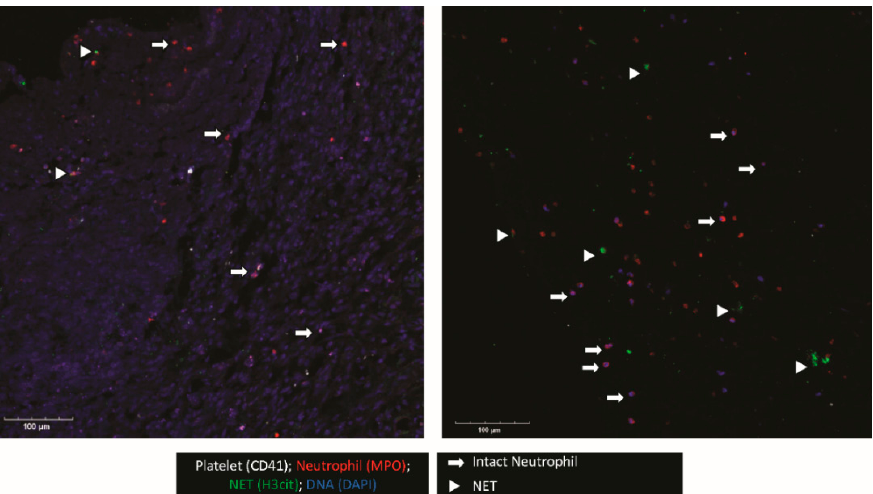
Figure 1. NETs and platelets are present in NASH outer membranes. The outer membranes of NASHs were collected, fixed, and embedded in OCT. Membranes were cryosectioned and stained for platelets (CD41, white), neutrophils (MPO, red), and H3Cit, a marker of NETosis (green). Nucleated cells were stained with DAPI (blue). The image shown is representative of three independent